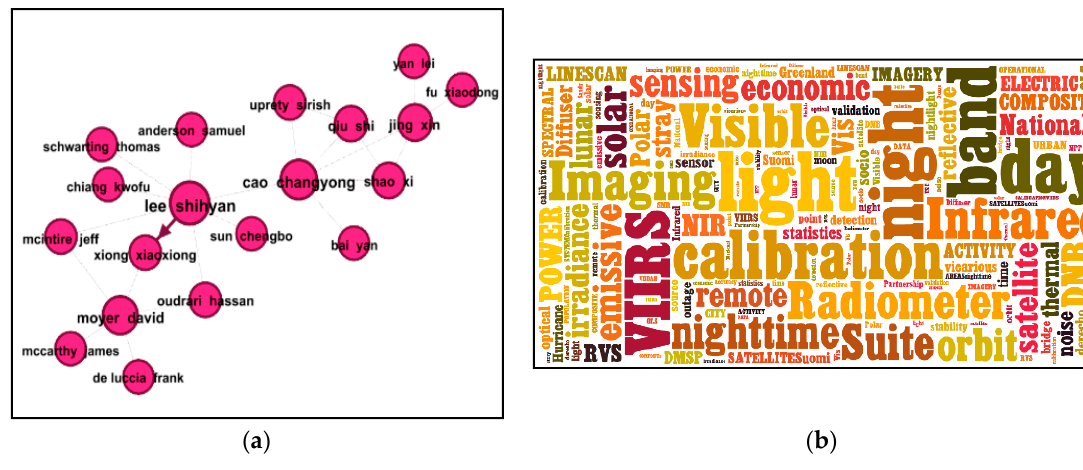
Figure 5. Lee, S.H.–Cao, C.Y. research community: ( a ) co-author network; ( b ) related topics.